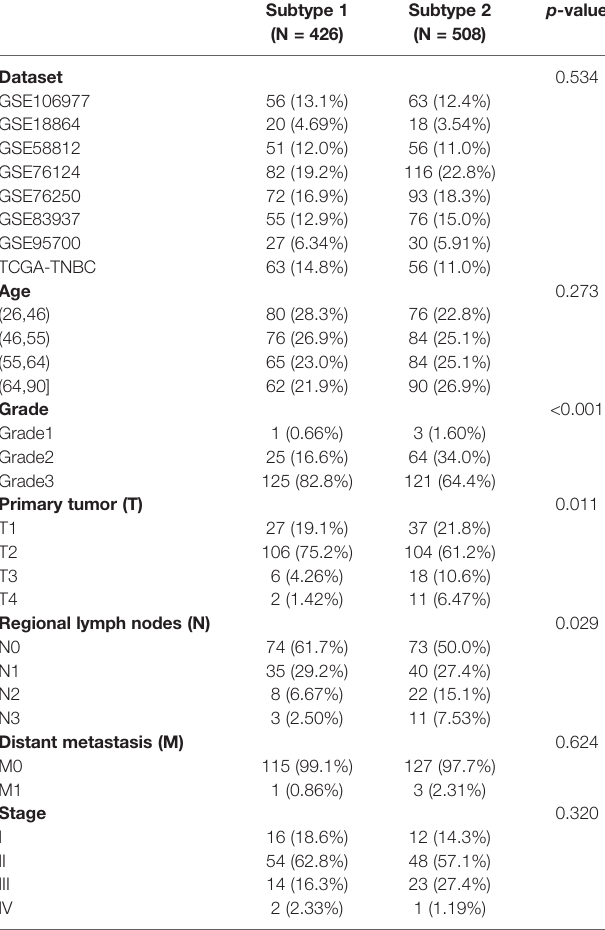
TABLE 1 | Distribution of clinical characteristics among two immune